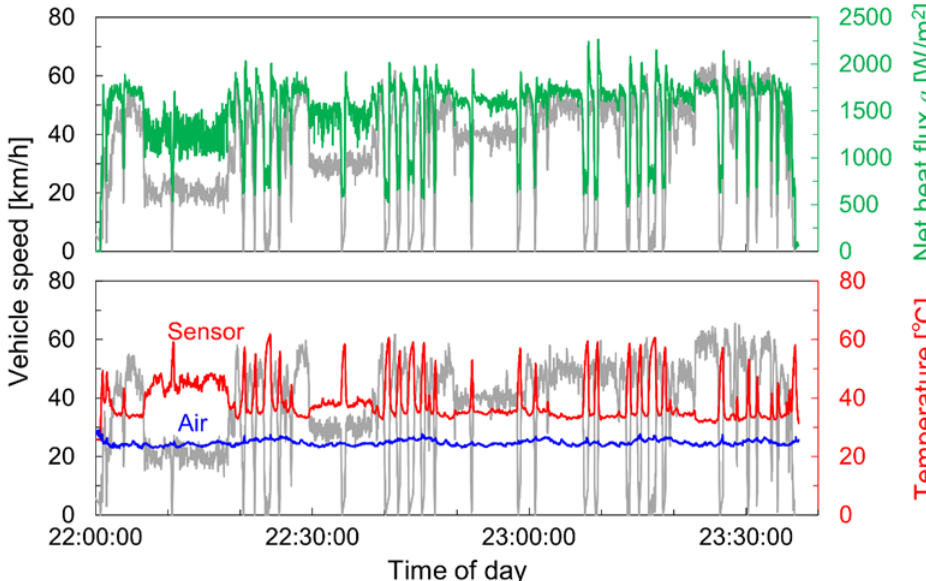
Figure 5. Measured values at the FI position and anemometer for the small van: vehicle speed (gray), net heat flux (green), sensor temperature (red), and air temperature (blue).